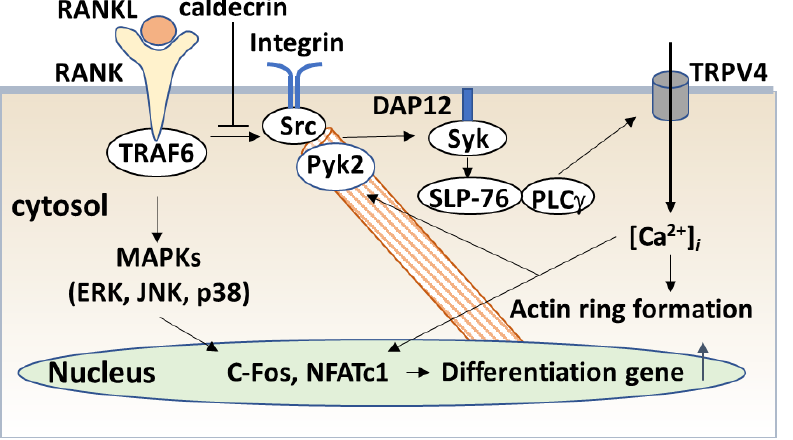
Figure 5. Caldecrin inhibits RANKL signaling in mature osteoclasts. RANKL–RANK binding activates c-Fos and NFATc1. RANK also activates c-Src and the c-Src–Syk complex. Activated Syk phosphorylates PLC γ via SLP-76, which leads to the activation of TRPV4 channels and evokes Ca 2+ influx. Increased Ca 2+ levels activate Pyk2 and are associated with Src, leading to cytoskeletal organization. Caldecrin inhibits RANKL-induced phosphorylation of c-Src, Syk, PLC γ , SLP-76, and Pyk2 in mature osteoclasts. Caldecrin also abolishes Ca 2+ entry into the cytoplasm through the TRPV4 channel and TRAF6–c-Src interaction. Akt: AKR mouse thymoma kinase; Src, sarcoma; SLP-76:SH2 domain containing leukocyte protein of 76kDa; TRPV4: Transient Receptor Potential Vanilloid